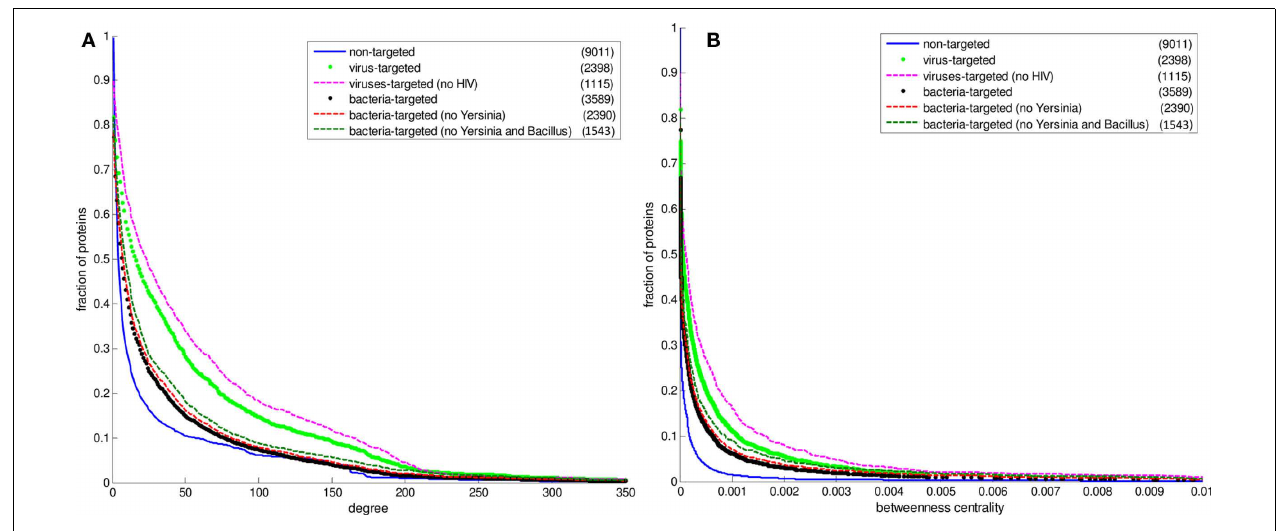
FIGURE 4 |The cumulative distributions of degree and betweenness centrality of human proteins excluding Yersinia and HIV data. The number of proteins in each set is given in the parentheses. (A) The degree